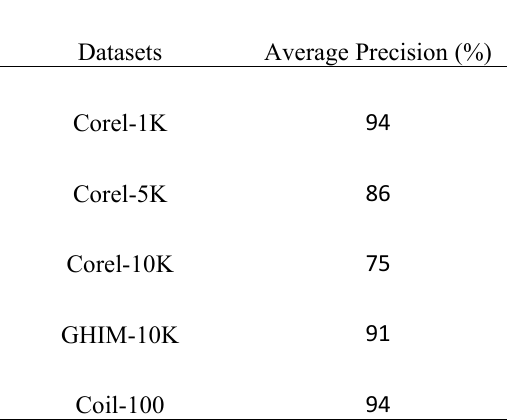
Figure 5. Sample images of all datasets